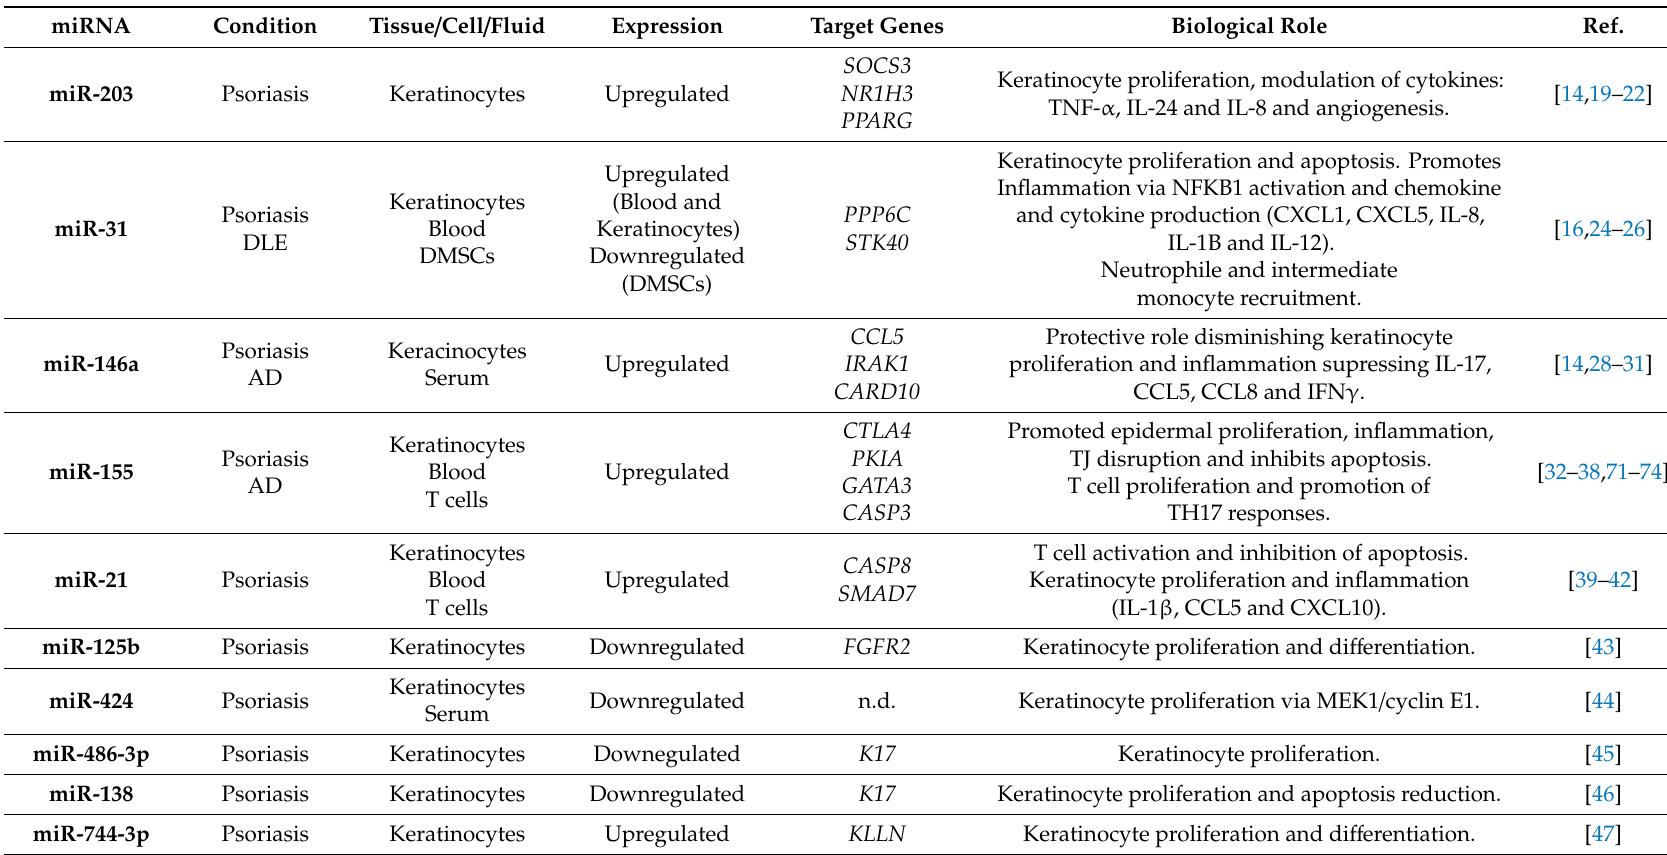
Table 1. Di ff erentially expressed mRNAs in skin immune diseases. Tissue / cell / fluids in which microRNAs (miRNAs) are found dysregulated, miRNA expression, validated experimentally target genes, and their biological role in the skin are